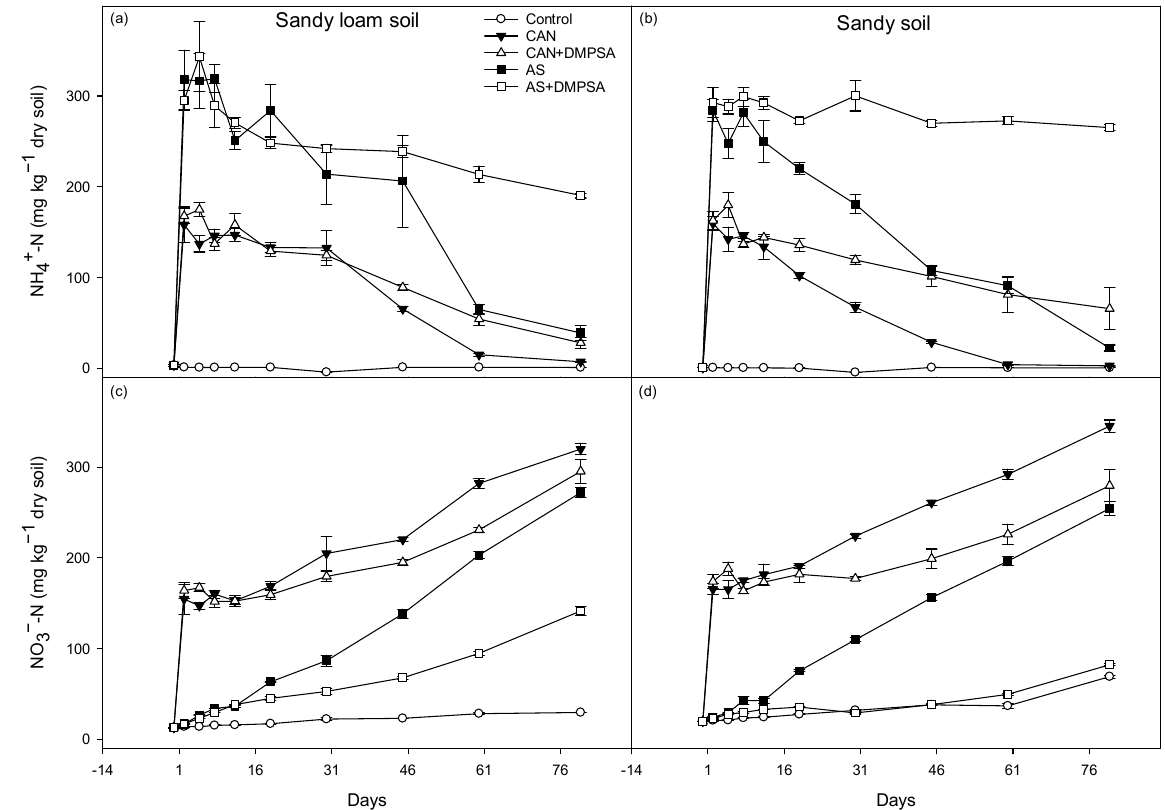
Figure 1. Changes in the NH 4+ -N and NO 3 − -N concentrations during the 80-day incubation period at 15 ◦ C in a sandy loam soil ( a , c ) and a sandy soil ( b , d ) receiving different fertiliser treatments. Error bars represent the mean ± 1 SE ( n =